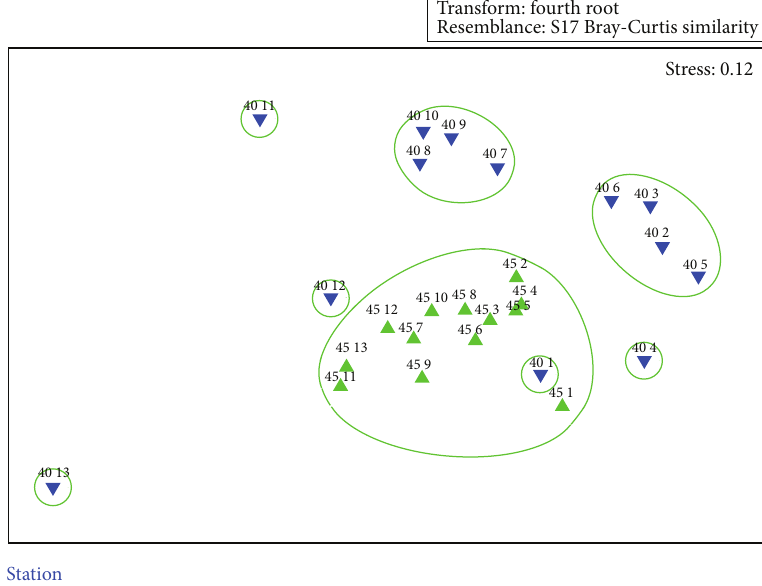
Figure 5: nMDS plot of samples from each cm of sediment cores collected at stations 40 and 45 in Bay of Vlor¨e. Hierarchical clustering superimposed with cutoff at 70% similarity.